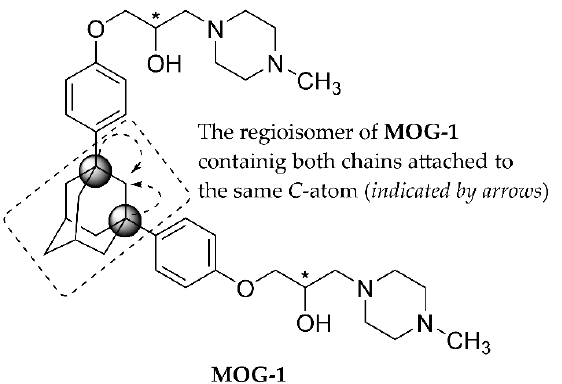
Mycobacterium tuberculosis H 37 R v compared to its regioisomer. (* = chiral center).